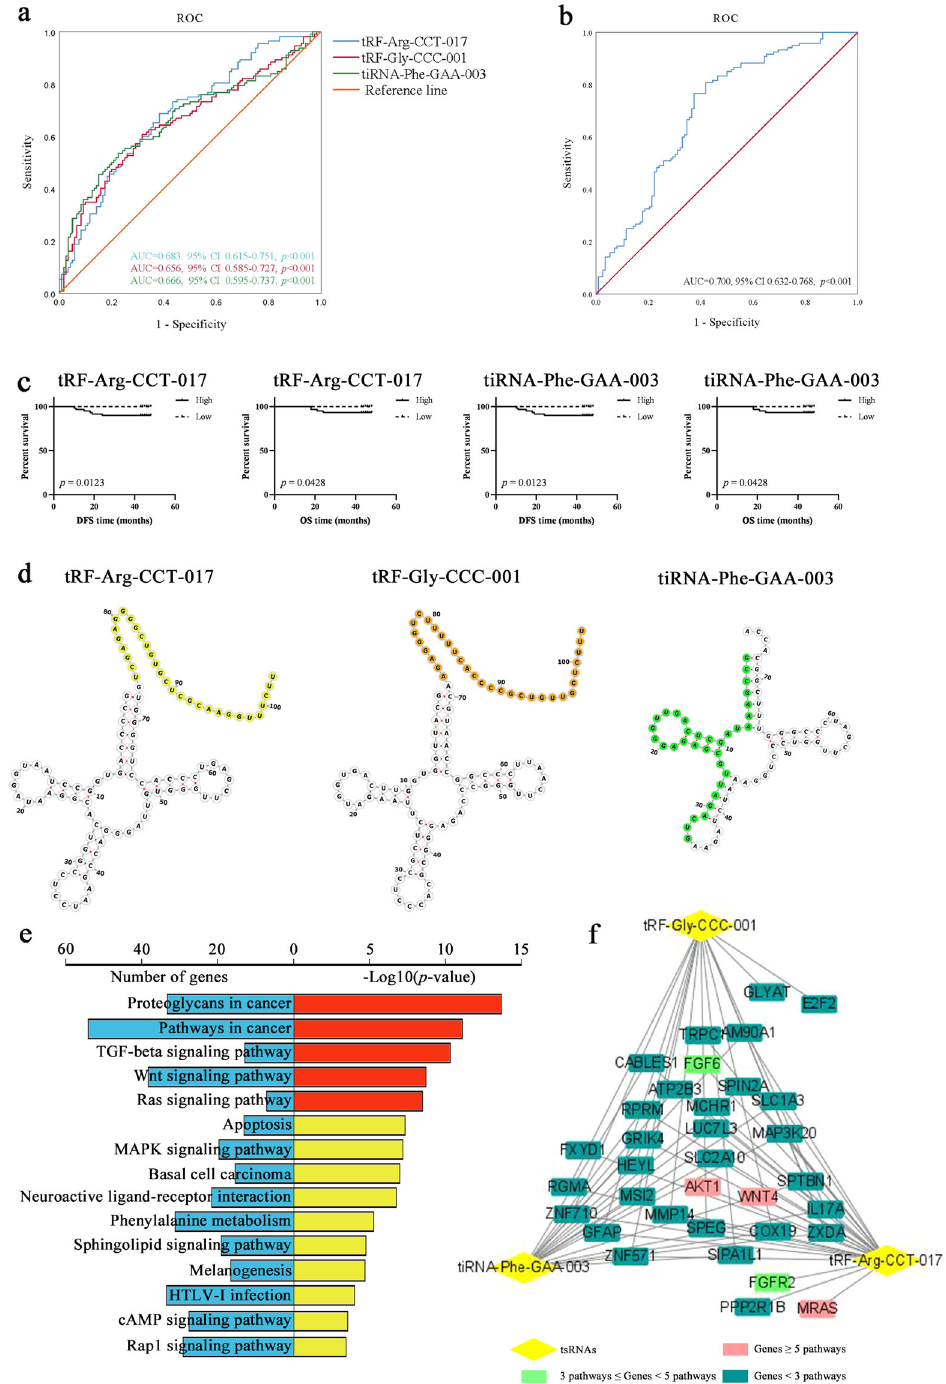
Fig. 2 The diagnostic and prognostic values of identi fi ed tsRNAs. a ROC curves of three tsRNAs for distinguishing patients with BC from healthy controls. b ROC curves of the three-tsRNAs panel. c High expression levels of tRF-Arg-CCT-017 and tiRNA-Phe-GAA-003 indicated worse DFS and OS. d Diagrams of secondary structures predicted by Vienna RNA Web Services. tRF-Arg-CCT-017 and tRF-Gly-CCC-001 were tRF-1 fragments, and tiRNA-Phe-GAA-003 was a 5 ′ tiRNA fragment. e KEGG pathways enriched for tRF-Arg-CCT-017, tRF-Gly-CCC-001, and tiRNA-Phe-GAA-003, and most were cancer-related. f tsRNAs-gene connection network. Yellow rhombuses represent tsRNAs. The pink, green, and blue rectangles represent target genes that were involved in ≥ 5, 3 – 5, and <3 signi fi cant pathways,